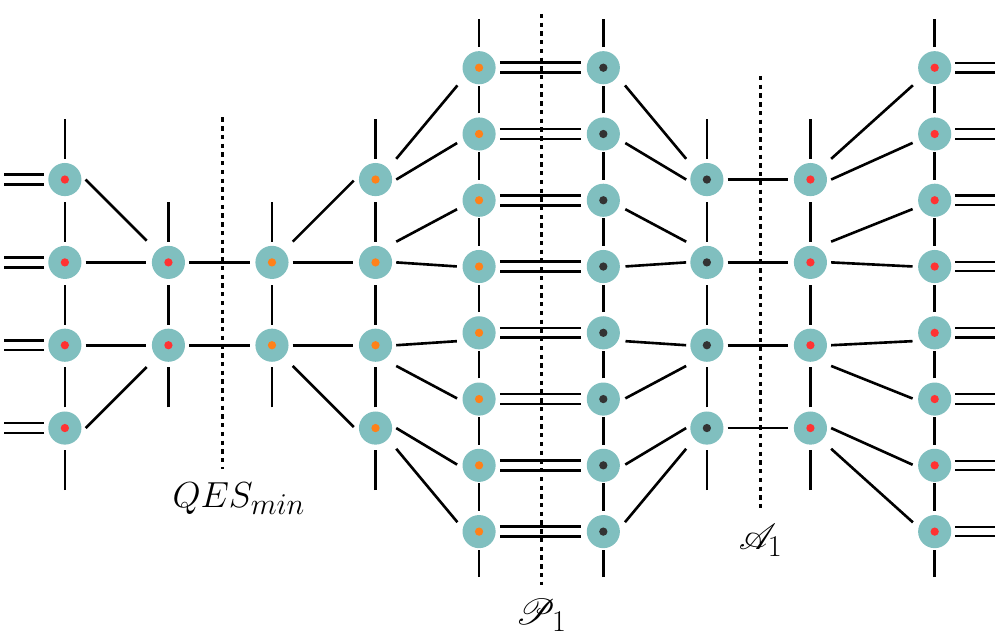
Figure 7 . We draw the tensor network diagram of the Python’s lunch geometry. In this diagram, the first and the last vertical legs in each column are identified. Each circle represent a perfect tensor with six legs. The minimal dotted cut-line represents the QES min , the dotted line labeled by P 1 the bulge and the one labeled by A 1 the appetizer. The isometry T 1 maps from H Q to H P The orange colored dots between the QES min and the bulge P 1 represent ancilla qubits required in order to make the map T 1 be unitary. The map from H P isometry T 2 . This requires a post-selection and the black dots represent the post-selected